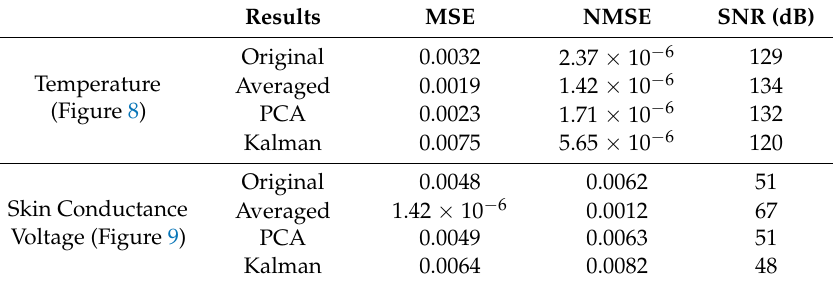
Table 1. MSE/NMSE/SNR parameters’ comparison for Figures 8 and